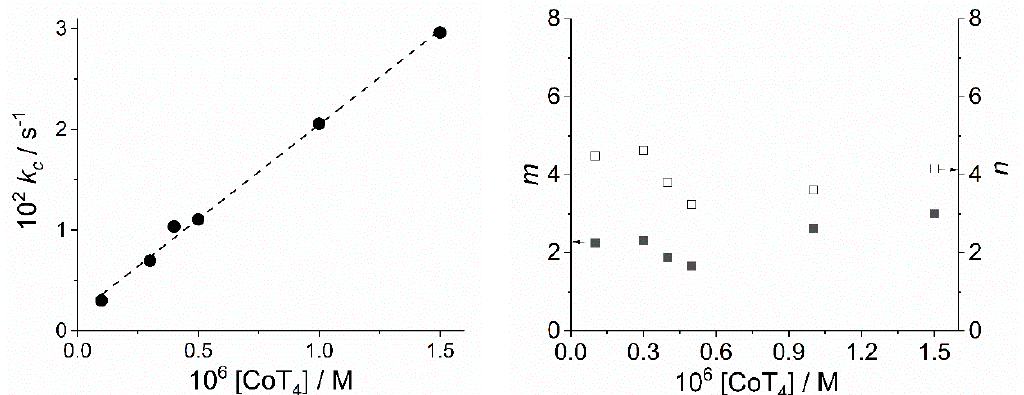
Figure 3. Plot of the autocatalytic rate constants k c (s − 1 ) ( left ), the line represents the linear fit of the experimental data to the equation k c = (1.7 × 10 − 3 ± 5 × 10 − 4 ) + (1.88 × 10 − 2 ± 6 × 10 − 4 ) × [CoT 4 ], and the values of m (full squares) and n (empty squares) for the aggregation of TPPS 4 as a function of [CoT 4 ] ( right ). (Experimental conditions: [TPPS 4 ] = 3 μ M; [HCl] = 0.00158 M, T = 298 K).